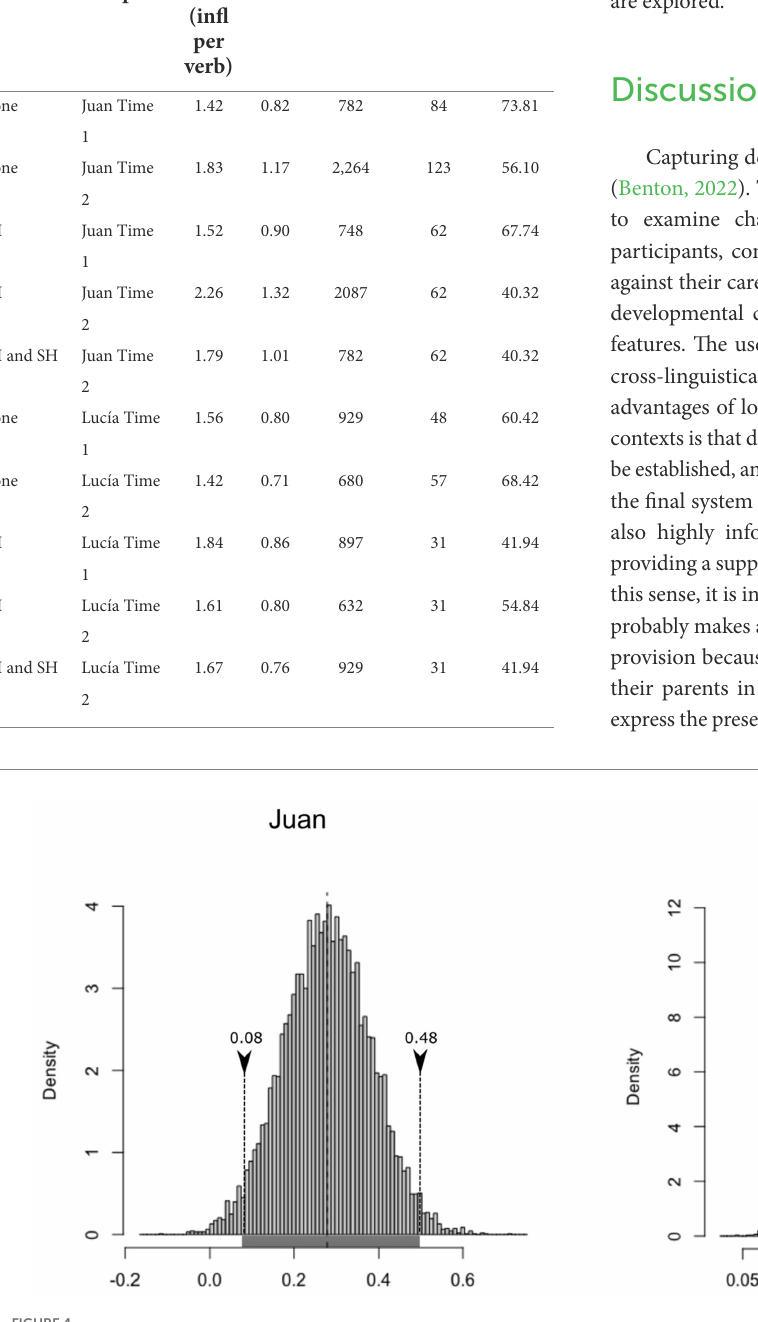
FIGURE 4 Histogram of the bootstrapped replicates of the differences in inflections per verb at Time 2 and Time 1 in the two Spanish speaking